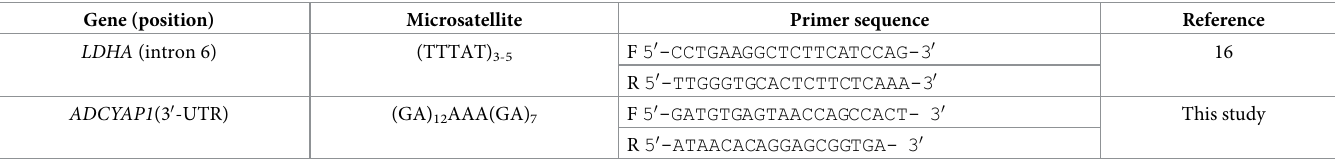
Table 1. Primer sequences and target